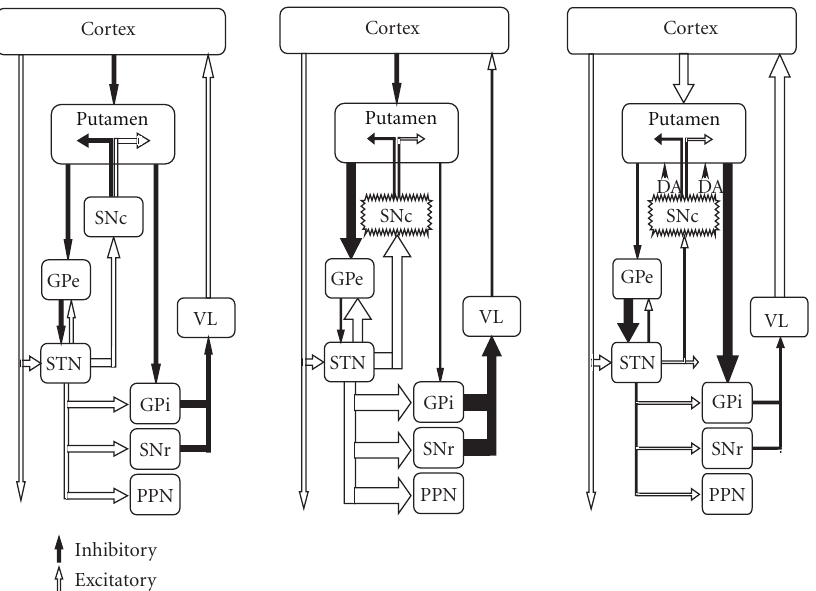
Figure 2: Classic model of basal ganglia in normal condition, parkinsonian, and dyskinetic conditions. During LID the di ff erent population of striatal cells from direct and indirect circuit are opposite to parkinsonian state. LID would result from a decrease in the inhibitory pathway by striatal neurons in the indirect pathway to the GPe, leading to an inhibitory increment over the STN and consequently reducing STN and GPi/SNr activity. This is facilitated by the increase in the inhibitory striatal activity of GPi by the direct pathway from striatum.